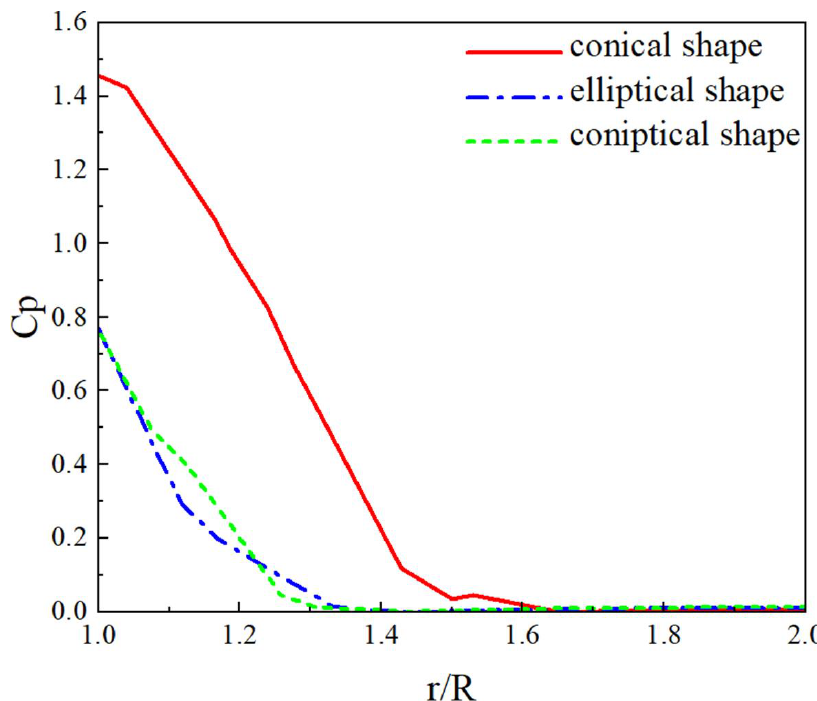
Figure 17. Total pressure loss coefficient 𝐶 𝑝 behind the spinner.